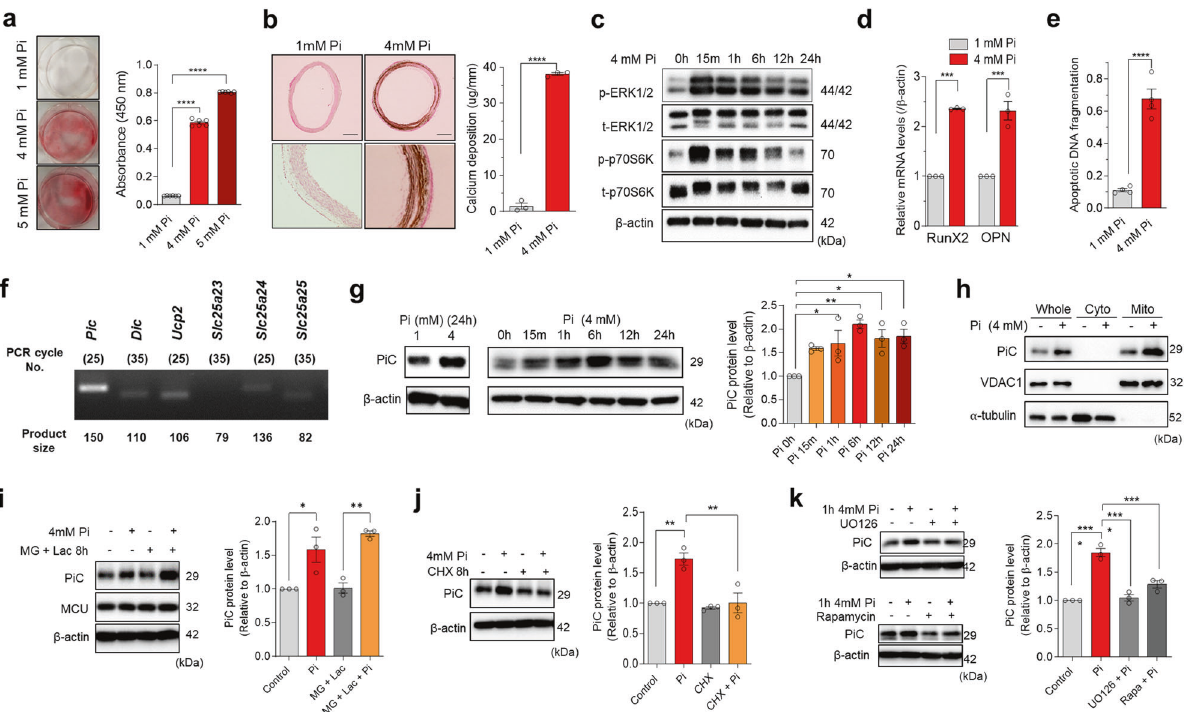
Fig. 1 High extracellular phosphate (Pi) increases the abundance of Pi carrier (PiC) and elicits vascular calci fi cation in primary vascular smooth muscle cells (pVSMCs) and rat aortic rings. a Calci fi cation of pVSMCs was visualized by Alizarin Red S staining upon Pi treatment for 48 h (# experiments; n = 6). b Thoracic aortic rings isolated from SD rats were cultured in calcifying medium (1 mM and 4 mM Pi) for 7 days, and calcium deposition was detected using von Kossa staining with a dark brown color (# rats; n = 4). c Time-dependent activation of ERK1/2 and mTOR by 4 mM Pi incubation in pVSMCs was determined using western blotting (# experiments; n = 3). d The transcript levels of osteogenic genes were estimated using quantitative PCR upon 1 mM and 4 mM Pi treatment for 48 h (# experiments; n = 3). e Apoptotic DNA fragmentation of pVSMCs was measured after 48 h of incubation with medium containing high levels of Pi (# experiments; n = 4). f Endpoint PCR analysis to check the expression of the mitochondrial phosphate transporters PiC, DiC, UCP2, slc25a23, alc25a24, and slc25a25 in pVSMCs (# experiments; n = 3). g Time-dependent increase in PiC protein expression after high-Pi incubation as revealed by immunoblotting (# experiments; n = 3). h PiC expression and upregulation by high Pi in cytosolic and mitochondrial fractions of pVSMCs. i Effects of proteasomal inhibitors (MG132 + lactacystin) on the upregulation of PiC after 1 h of treatment with 4 mM Pi (# experiments; n = 3). j Protein expression of PiC in pVSMCs after preincubation with CHX for 8 h followed by 1 h of high Pi culture (# experiments; n = 3). k Effects of UO126 and rapamycin on the increase in PiC after treatment of pVSMCs with elevated Pi-containing medium (# experiments; n = 3). The data were analyzed by either two-tailed Student ’ s t test or one-way ANOVA. * P < 0.05; ** P < 0.01; *** P < 0.001; **** P <